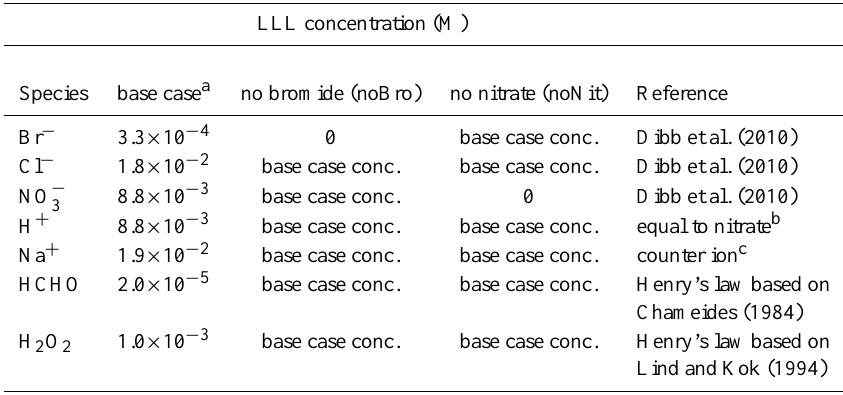
Table 1. Liquid layer concentrations for the base case and sensitivity model runs conducted based on measurements taken in June 2008 as well as previous measurements at Summit,